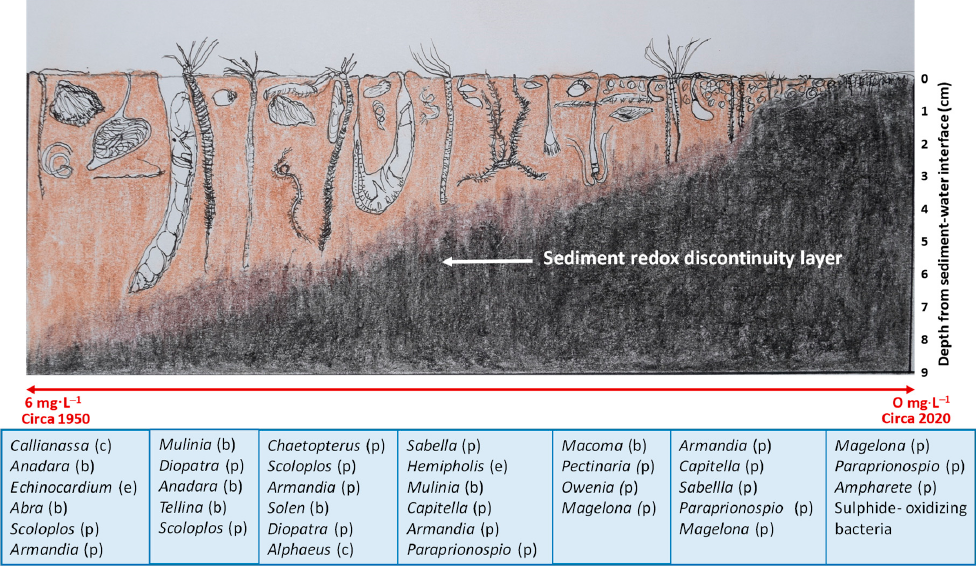
Figure 3. Changes in benthic infauna (by genera) and sediment structure including the redox discontinuity layer from well-oxygenated waters on the left, likely representing years circa 1950, to no oxygen on the right, representing years circa 2020 (modified from [11,33]). (Letters are (b) bivalve, (c) crustacean, (e) echinoderm, (p) polychaete.)